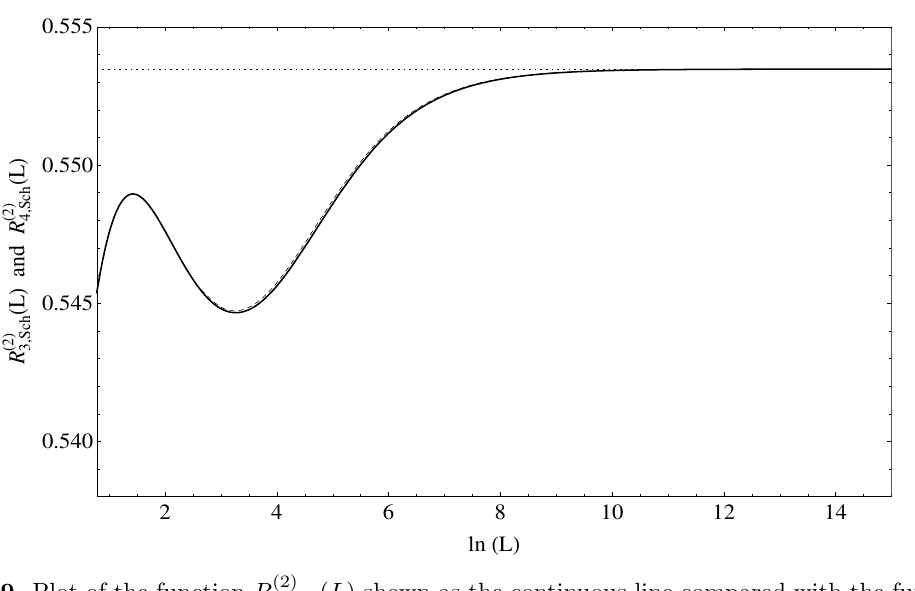
Figure 9 . Plot of the function R (2) ( L ) shown as the continuous line compared with the function 3 ; Sch R (2) ( L ) represented as the dashed line for the tachyon vev as a function of the level in Schnabl 4 ; Sch gauge. The dotted line represents the asymptotic value 0 : 5534 obtained in reference